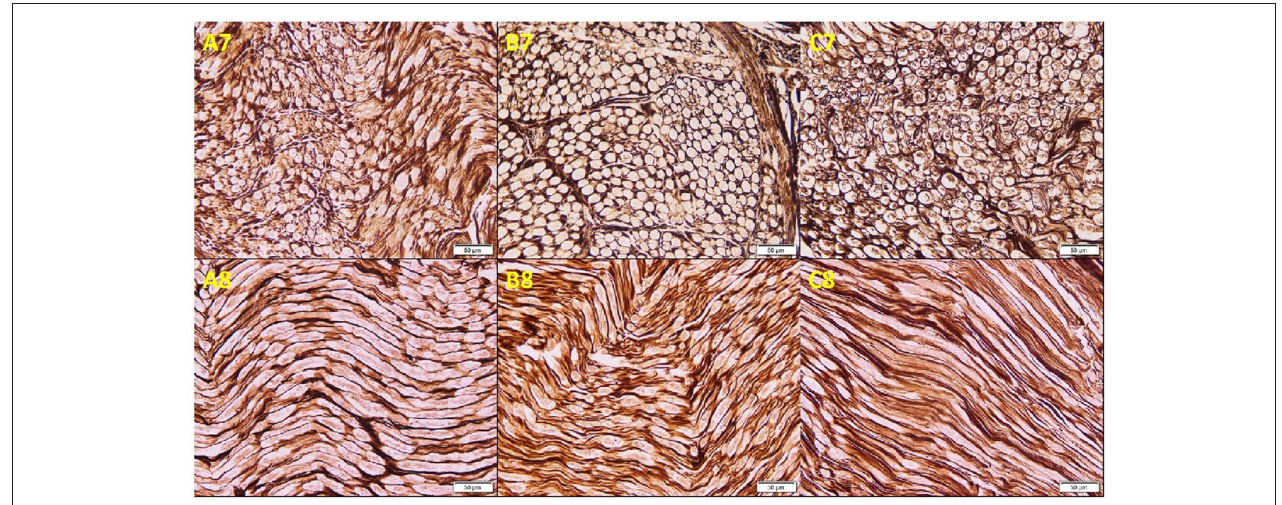
FIGURE 4 | Photomicrographs of the cadaveric median nerve sections demonstrating transverse sections in (A7, B7, C7) and longitudinal sections in (A8, B8, C8) of groups A, B, and C, respectively, illustrating apparently normal neurofibrils, Schwann cell nuclei, and axons stained brown in the arm, forearm, and wrist (silver impregnation, ×